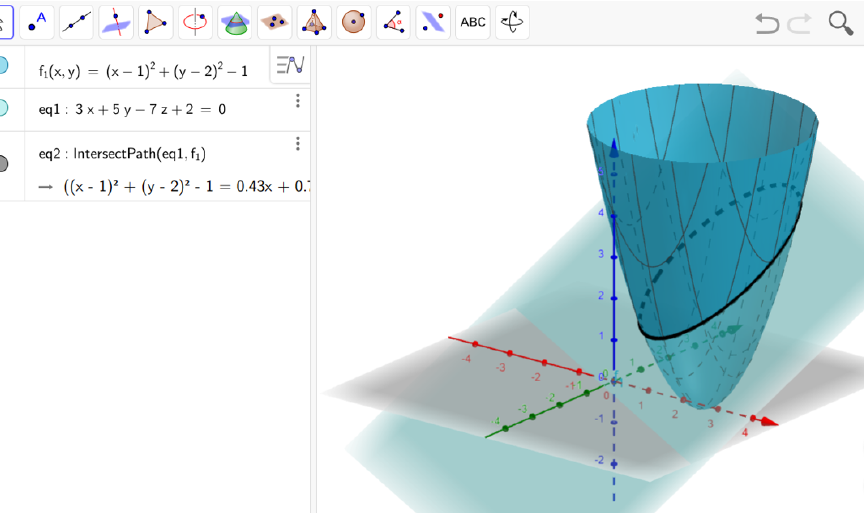
Figure 4. Intersection of two surfaces using